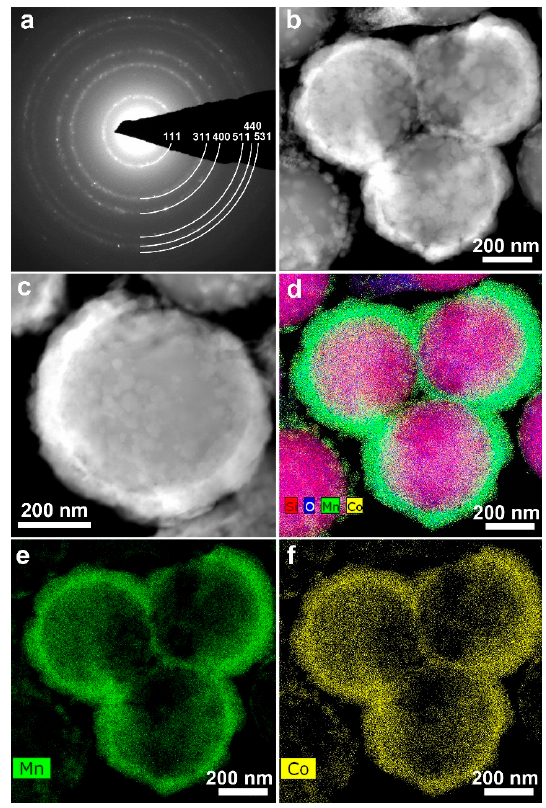
Figure 2. ( a ) Electron di ff raction pattern of the solution-coated SiO 2 spheres indexed with the Fd -3 m spinel structure; ( b , c ) HAADF-STEM images showing ca. 100 nm spinel coating layer around the SiO 2 spheres; ( d ) energy-dispersive X-ray (EDX) map of the Mn (green), Co (yellow), O (blue), and Si (red) distribution. ( e , f ) individual EDX maps of Mn and